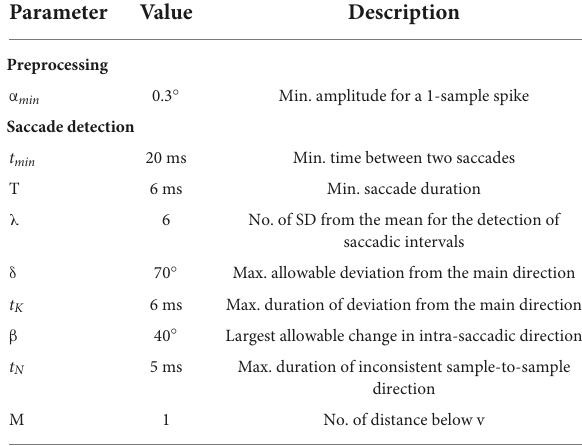
TABLE 1 Algorithm parameters for saccadic